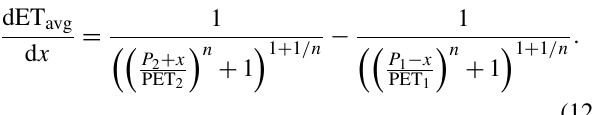
Figure 9. Average ET is maximized for the rate of net transfer at which P /PET and ET/PET of the two hypothetical columns of Fig. 8 cross one